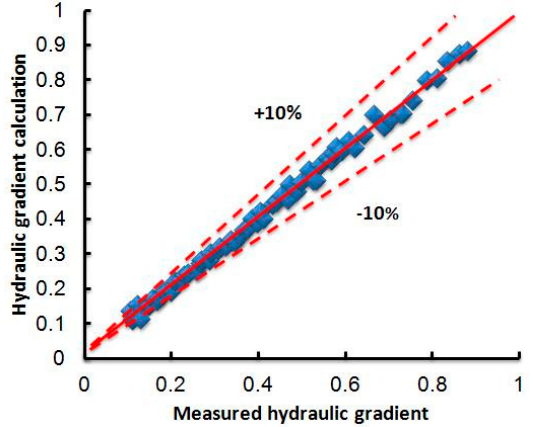
Figure 10. Comparison of predicted and experimental data of pressure drop.